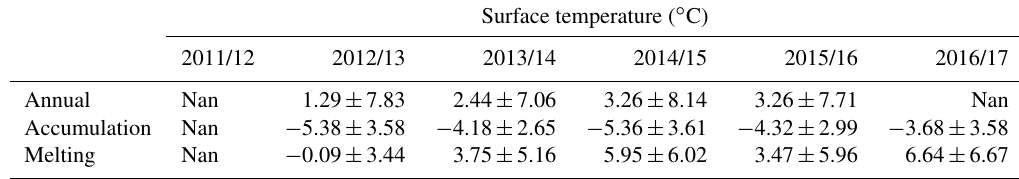
Table 5. Mean surface temperature from the infrared sensor for the five snow seasons for the annual, accumulation and melt periods.